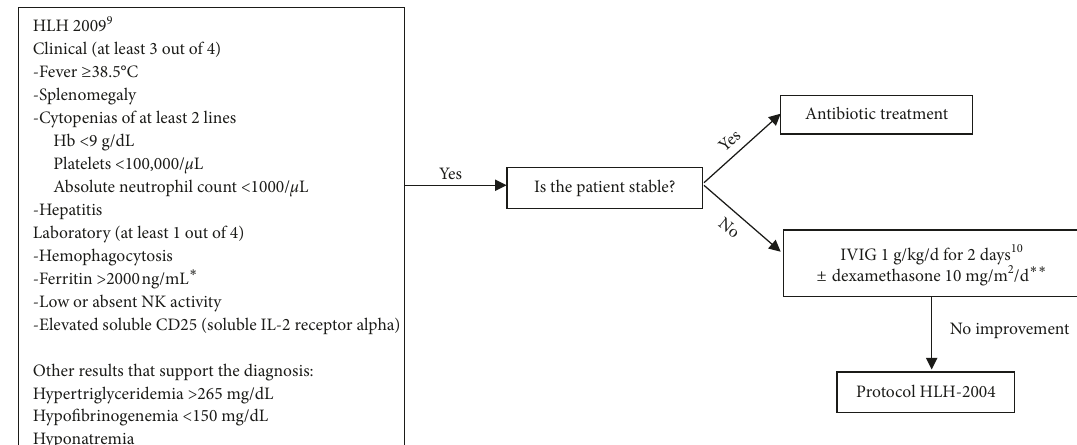
Figure 1: Approach to HLH secondary to Salmonella infection. IVIG � intravenous immunoglobulin; ∗ value suggested by authors; in the original diagnostic criteria, ferritin is > 500ng/mL; ∗∗ dexamethasone 10mg/m/d for 7 days followed by 6mg/m 2 /d until complete